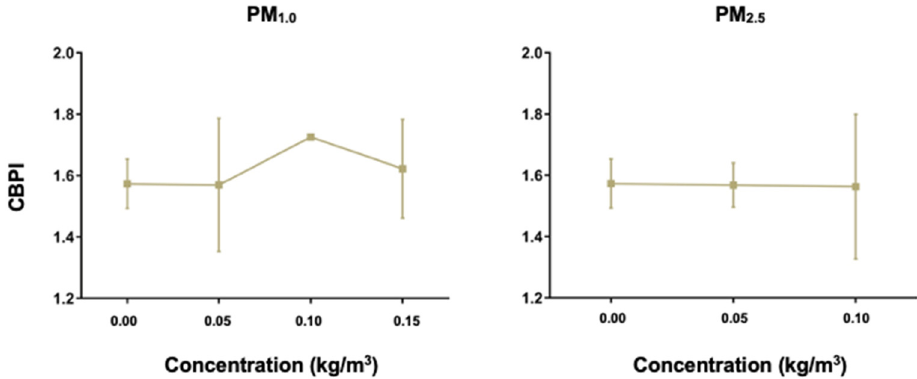
Figure 2. CBPI counts obtained from both PM size fractions.